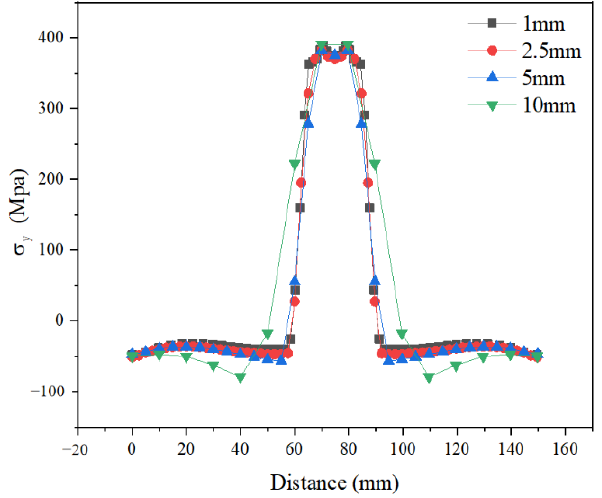
Figure 4. The stress results of models with different mesh sizes.